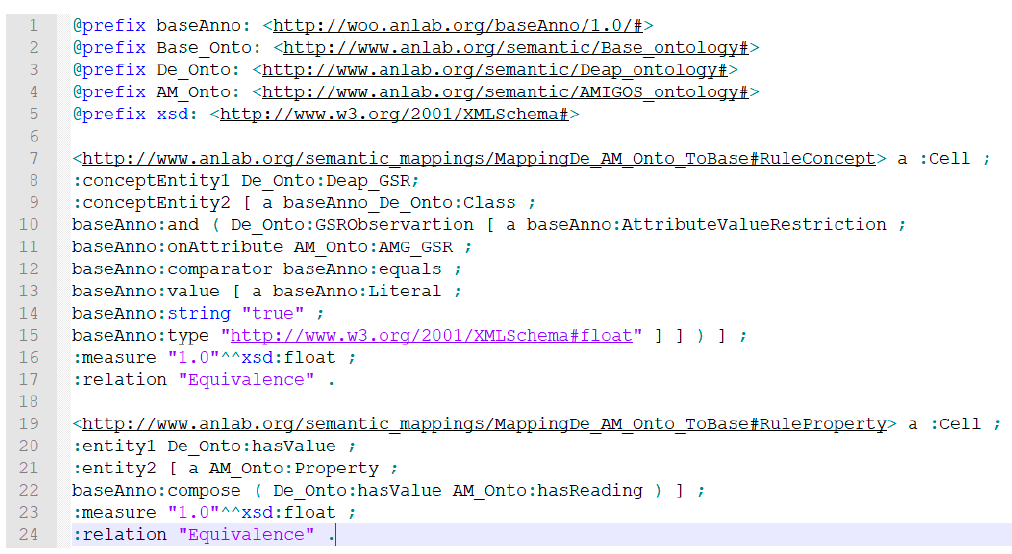
Figure 19. Code example of semantic annotation with the base ontology model through shared data mapping.